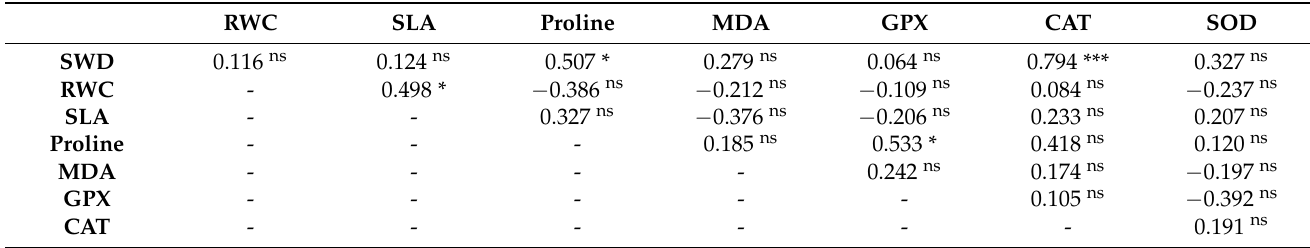
Table 6. Pearson’s correlation test among the studied traits (genotype: ‘Vulcano’). Significant at p ≤ 0.05 (*), and 0.001 (***); not significant (ns).